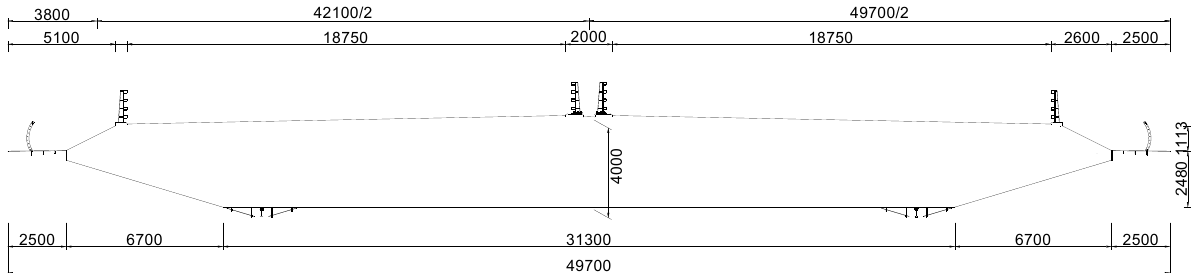
Figure 11. Girder cross-section of LDYB main span (unit: mm).